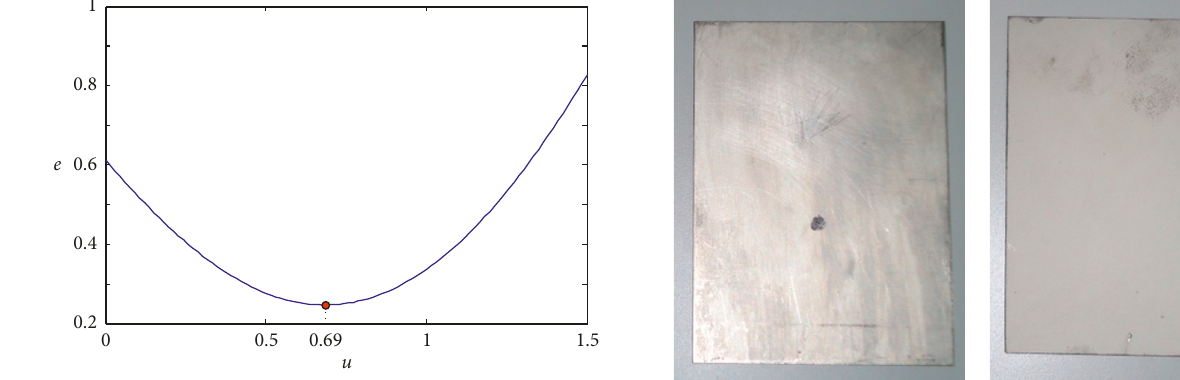
Figure 11: Search for the optimal solution.